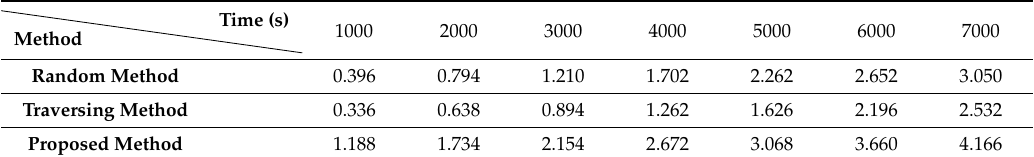
Table 1. Comparison of the number of targets found using dynamic targets.